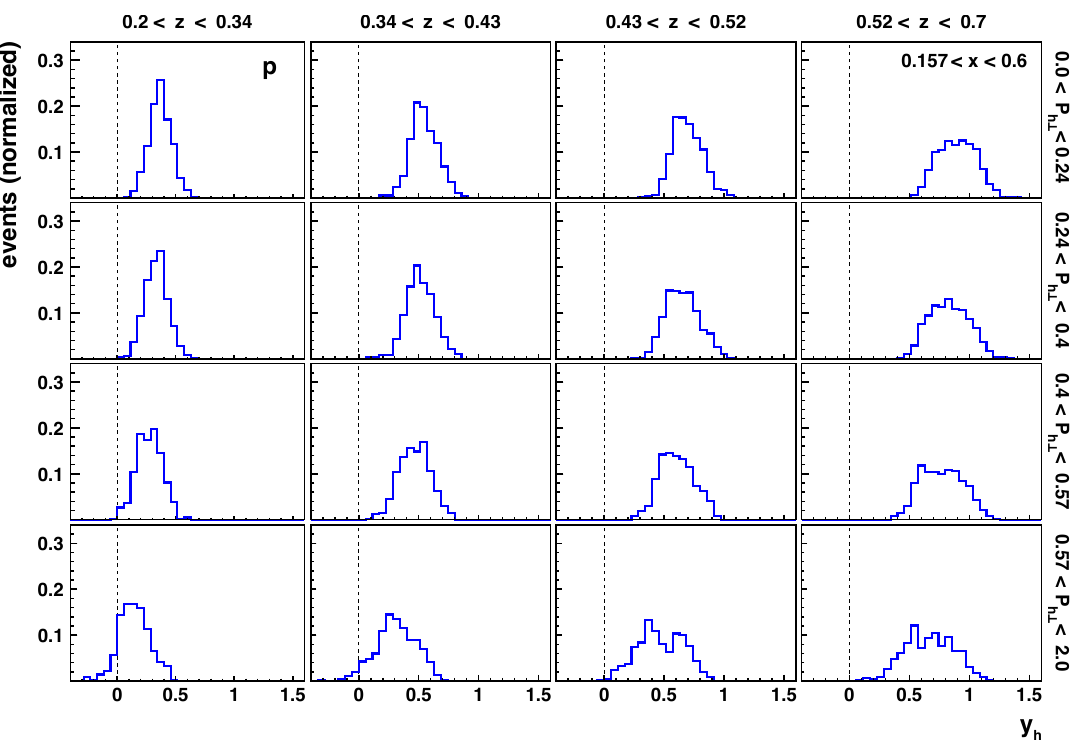
Figure 42 . Rapidity distributions for protons in the various ( z , P h ⊥ ) bins of the last x bin. The dashed lines indicate zero